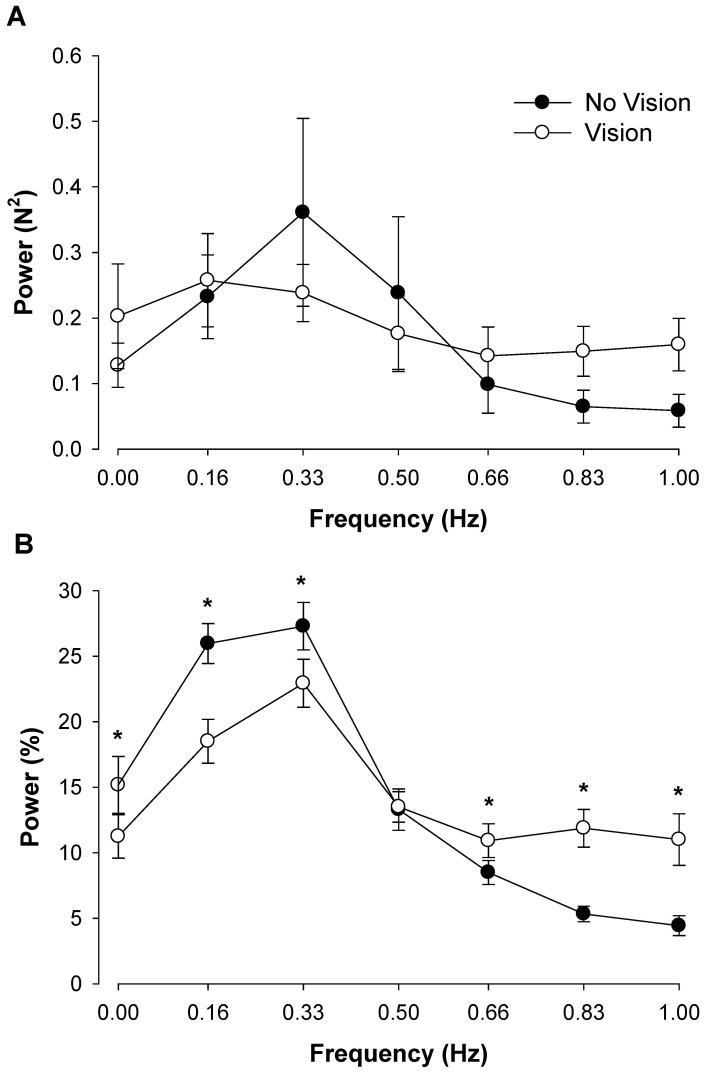
The effect of no visual feedback on force oscillations below 1 Hz.A: The absolute power during the two visual feedback conditions. The age and visual feedback condition main effects and associated interactions were not significant. B: The normalized power during the two visual feedback conditions. During the no visual feedback condition, normalized power in the force output at 0.16 Hz increased; whereas normalized power decreased from 0.83–1.0 Hz. Young and older adults exhibited a differential modulation of force oscillations below 1 Hz during the no visual feedback condition compared with visual feedback at the highest visual angle (1.5°). Asterisk (*) indicates significant difference (P<0.05) between the no visual feedback condition and the visual feedback condition.